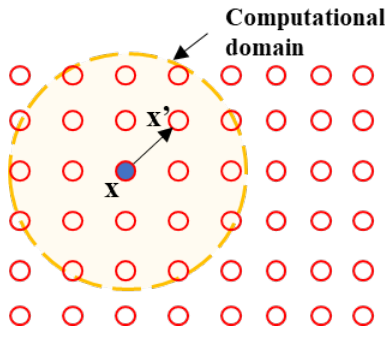
Figure 1. Interaction between particles.